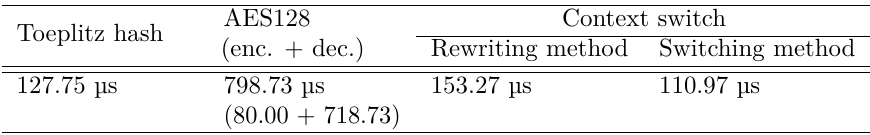
Table 6: Comparison of execution time (Arty